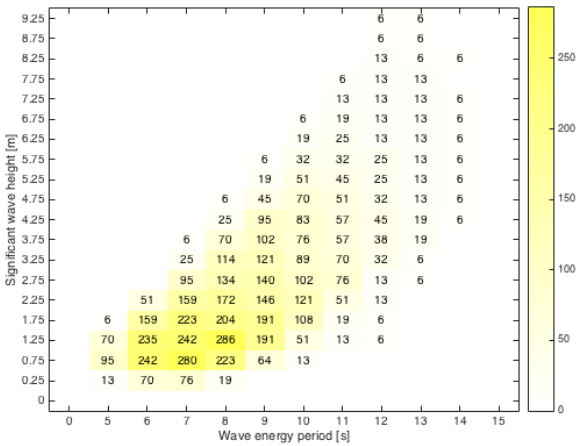
Figure 8. Corresponding energy matrix in kW on the west coast of Scotland (centre of area is at 57° N, 9° W). Numbers indicates occurrence in hours per year.